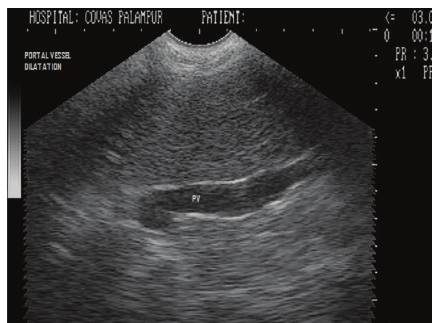
Figure 20: Dorsal sonogram (2D) of liver depicting hypoechoic parenchyma with portal vessel dilatation in one-year-old mixed- breed dog.